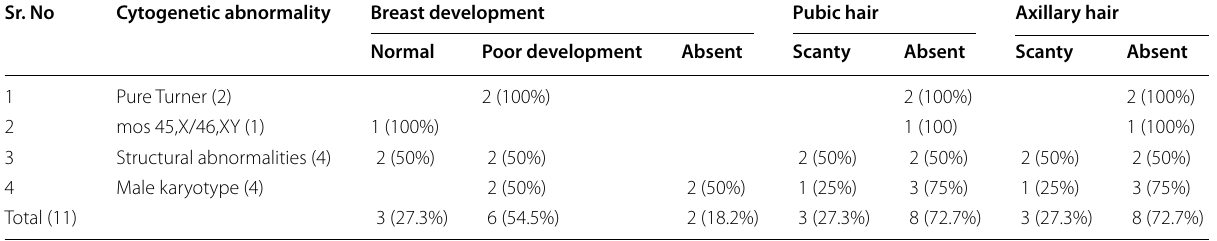
Table 3 Distribution of cytogenetic abnormality, Breast development and secondary sexual characters in PA Sr. No